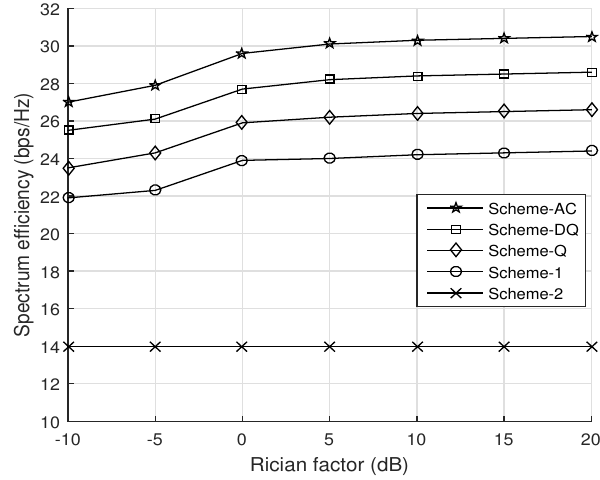
Figure 9. SE versus Rician factor